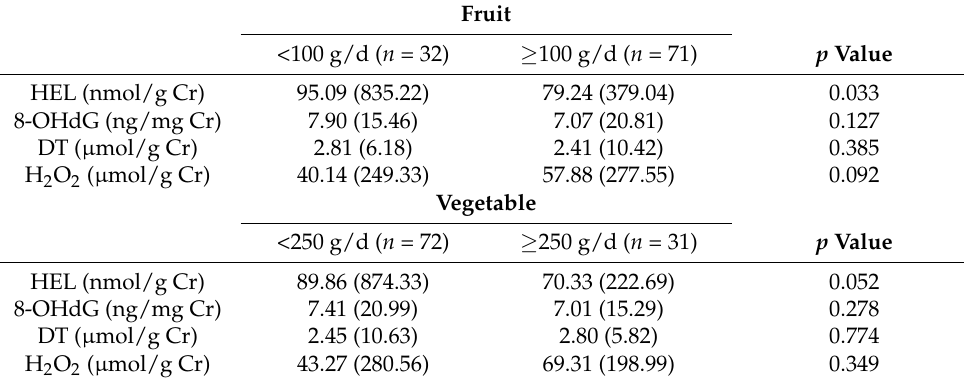
Table 2. Urinary biomarker concentrations by daily consumption of fruit and